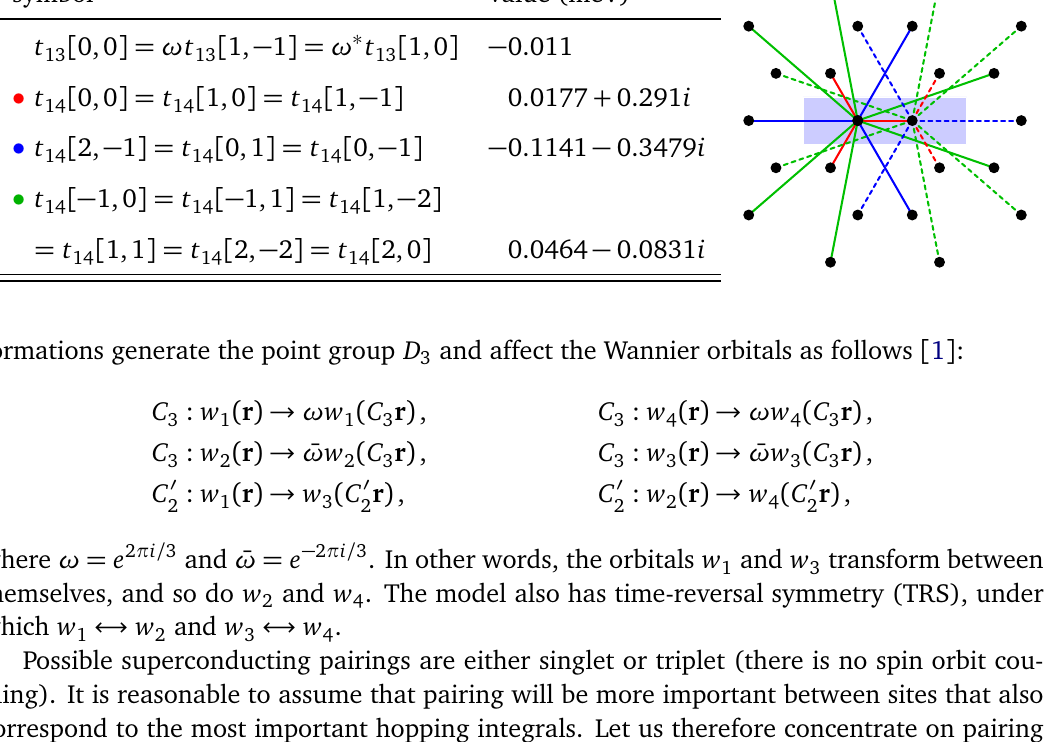
, E basis shown on Fig. 1. Note that 1 2 )